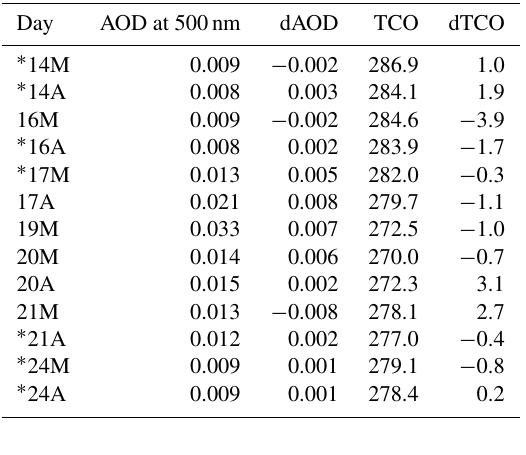
Table 1. Summary of the atmospheric conditions during the mea- surement campaign. For each half-day (indicated by M, morning, and A, afternoon) the aerosol optical depth at 500nm, the total col- umn ozone (TCO) in DU, and the change of AOD and TCO during the period is shown. The ∗ indicates that this half-day satisfied the criteria for inclusion in the average set.